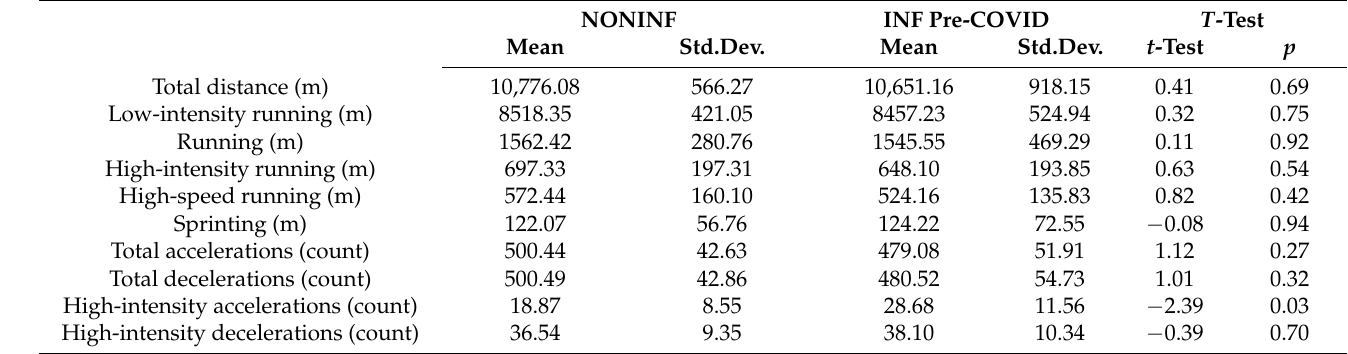
Table 1. Descriptive statistics for match running performances and independent sample T -test differences between non- infected players (NONINF) and infected players before being diagnosed with COVID-19 (INF pre-COVID). NONINF INF Pre-COVID T -Test Mean Std.Dev. Mean